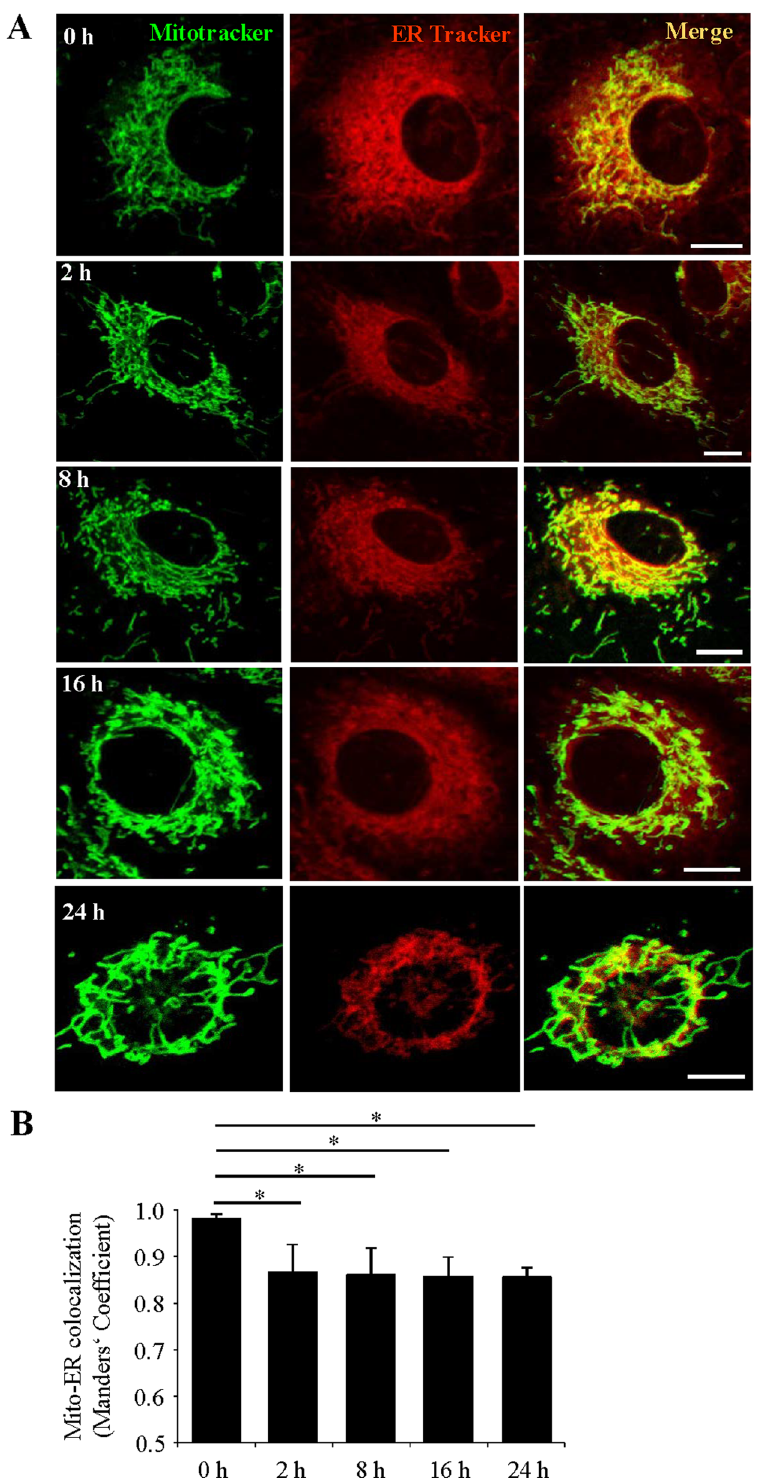
Figure 7. Acute high glucose treatment reduces ER-mitochondrial contact in retinal endothelial cells. ( A ) Representative confocal images of human retinal endothelial cells (HRECs) treated with 25 mmol/ml glucose (HG) for 0 to 24 hours, stained with MitoTracker (green) and ERTracker (red). Scale bars: 10 μ m. ( B) Quantification of the Manders’ coefficient M1 (fraction of mitochondria overlapping with the ER). Mean ± SD; n = 10–15 cells per group). * P < 0.05; one-way ANOVA with Tukey’s post hoc